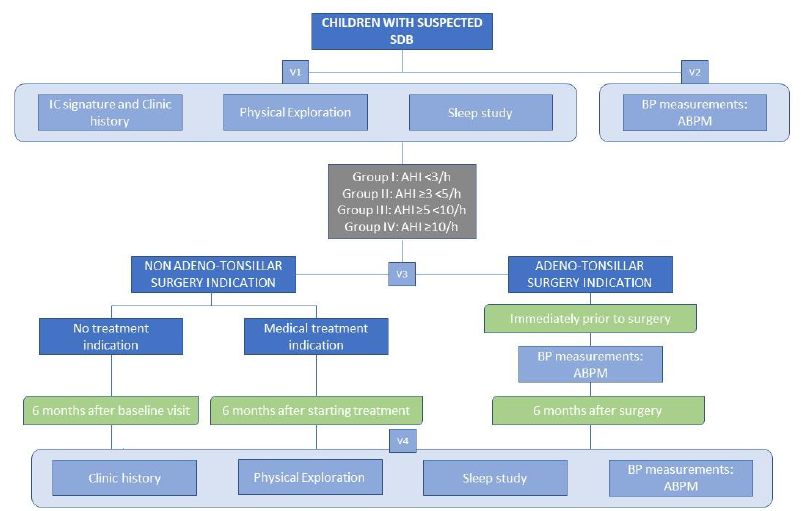
Figure 3. Flow diagram for the study procedure. Abbreviations: SDB, sleep-disordered breathing; IC, informed consent; BP, blood pressure; ABPM, ambulatory blood pressure monitoring; AHI,